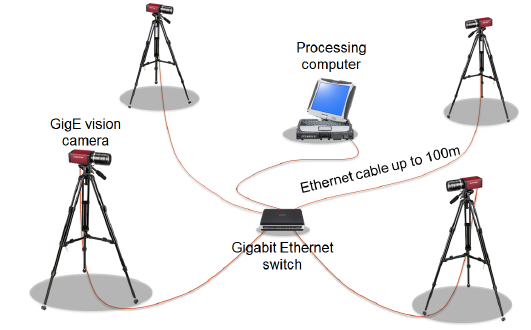
Figure 1. System configuration